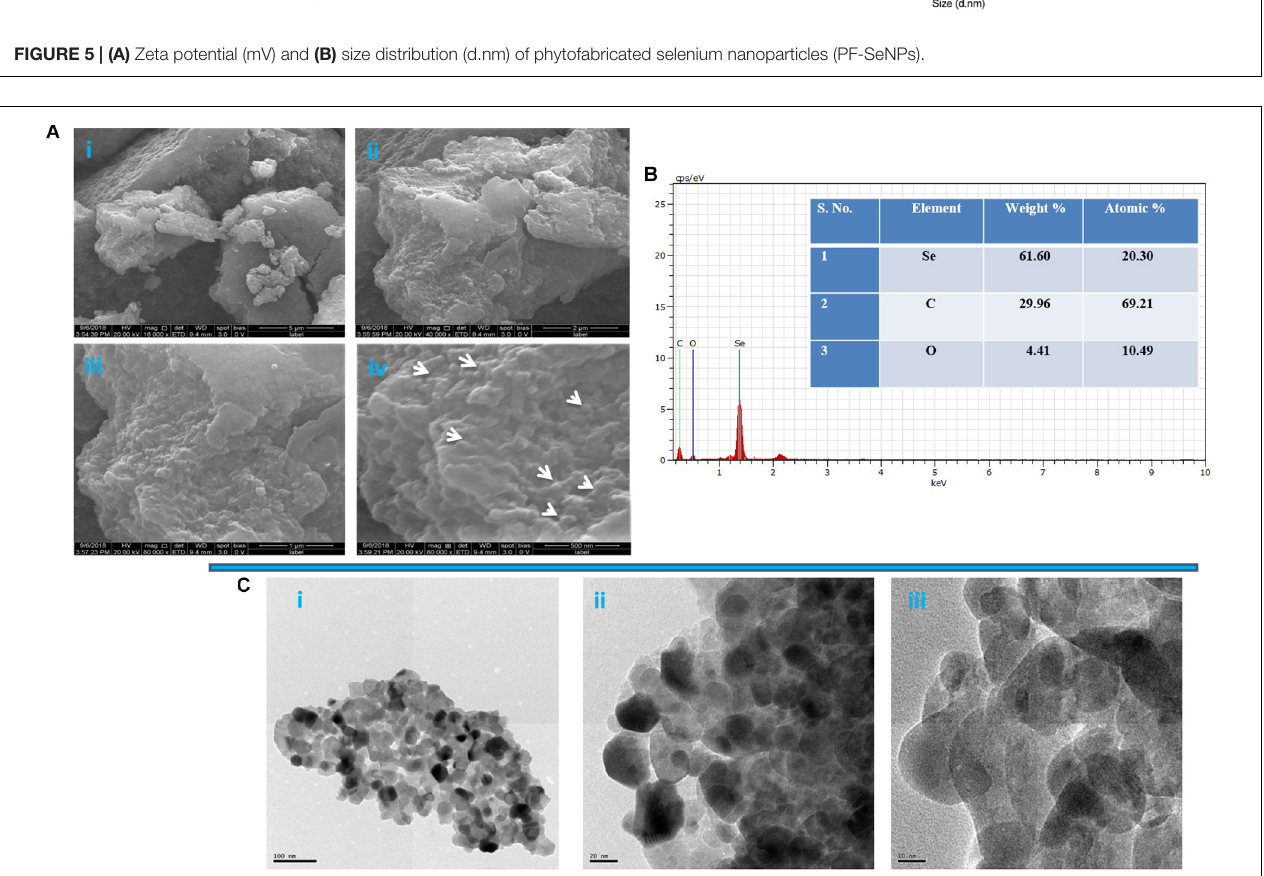
FIGURE 6 | (A) Scanning electron microscopic image of phytofabricated selenium nanoparticles (PF-SeNPs) at magnification of (i) 5 µ m, (ii) 2 µ m, (iii) 1 µ m, and (iv) 500 nm. (B) Energy-dispersive X-ray analysis of PF-SeNPs. (C) Transmission electron microscopic images of PF-SeNPs at (i) 100 nm, (ii) 20 nm, and (iii) 10 nm.